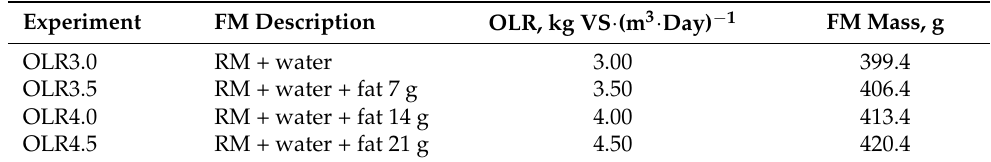
Table 1. Feeding material